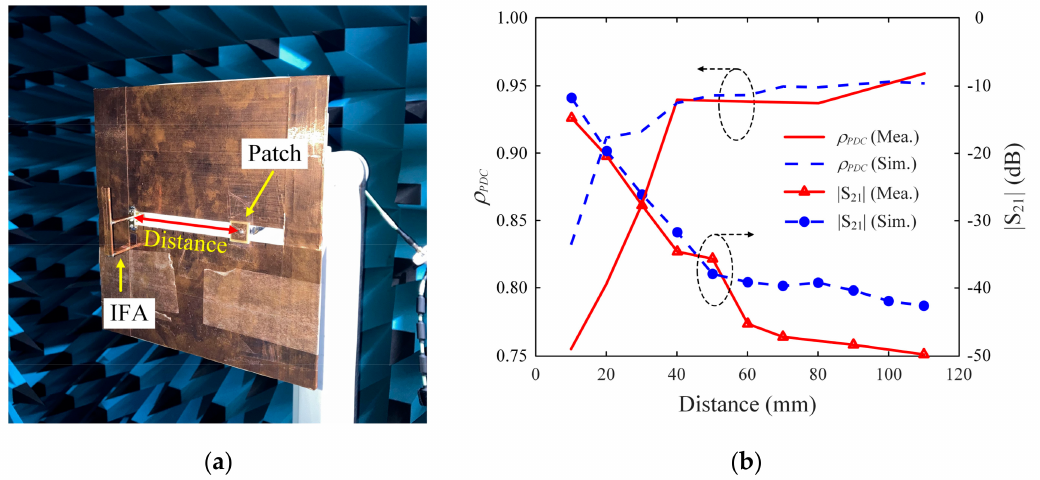
Figure 10. Photograph of the measurement set-up and the measured results. ( a ) Measurement of ρ PDC for the fabricated patch antenna in an anechoic chamber. ( b ) Simulated and measured results of ρ PDC and |S 21 | according to the